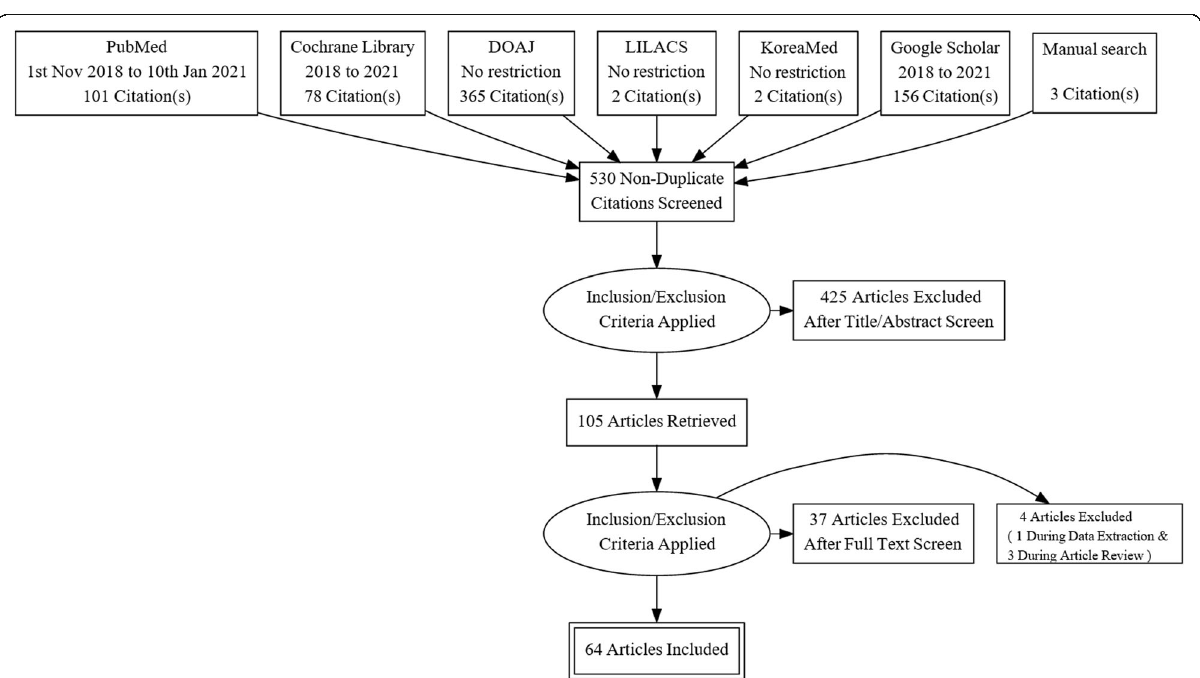
Fig. 1 PRISMA (the Preferred Reporting Items for Systematic Reviews and Meta-Analysis Extension) flow